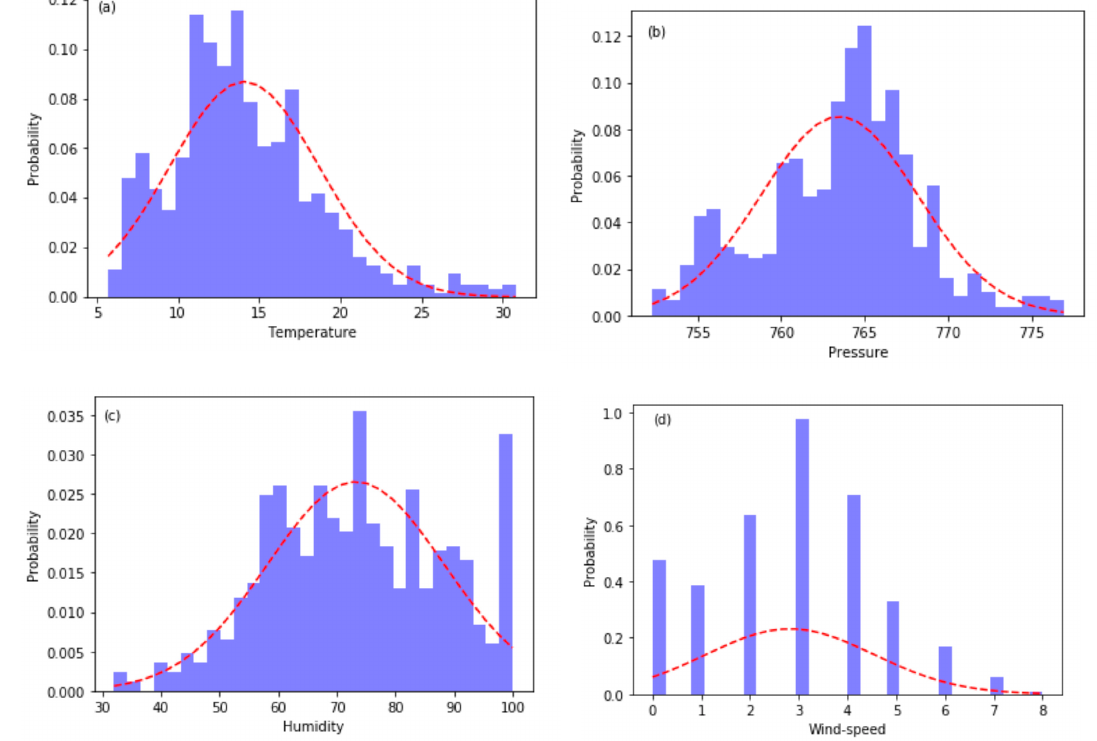
Figure 7. Features accord with Gaussian distribution. (( a ). Temprature ( b ). Pressure ( c ). Humidity ( d ). Wind-speed)